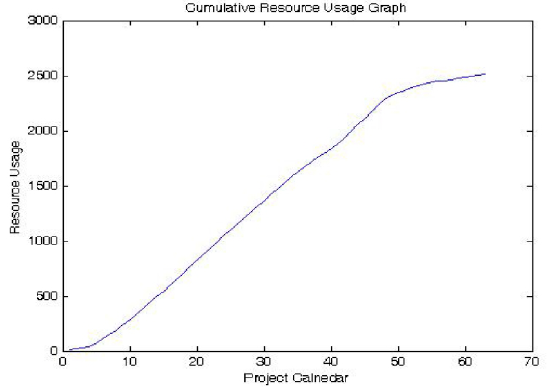
Figure 42. Cumulative resource usage for resource 1 of experiment 3 (relaxed resource constraint)